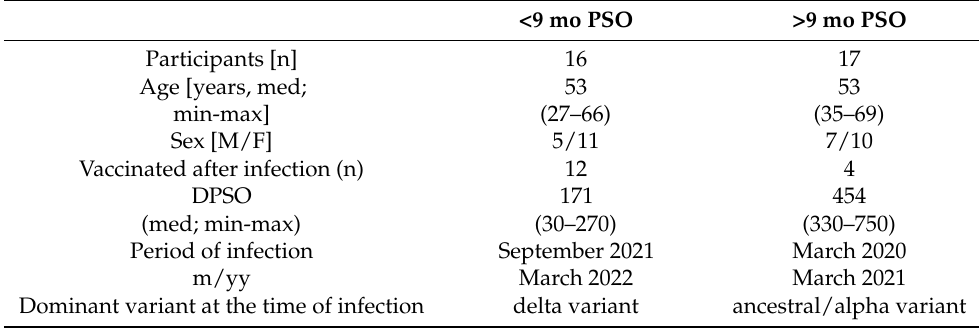
Table A2. Characteristics of groups tested less than 9 months and beyond 9 months after the